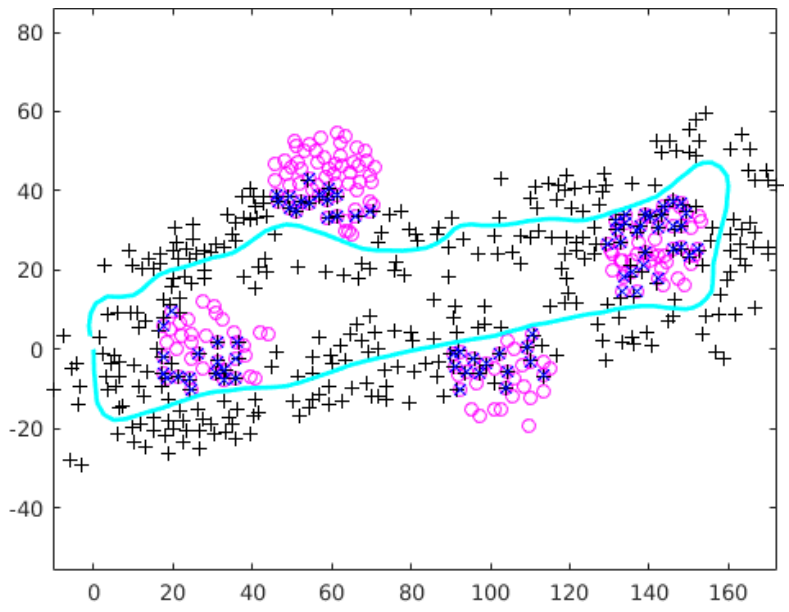
Figure 16. Älvan. Map over detected trees (black ‘+’), field measured trees (magenta ‘o’) and linked trees (black ‘+’ + magenta ‘o’ + blue ‘x’). The cyan line shows the vehicle trajectory, starting in [ 0,0 ]